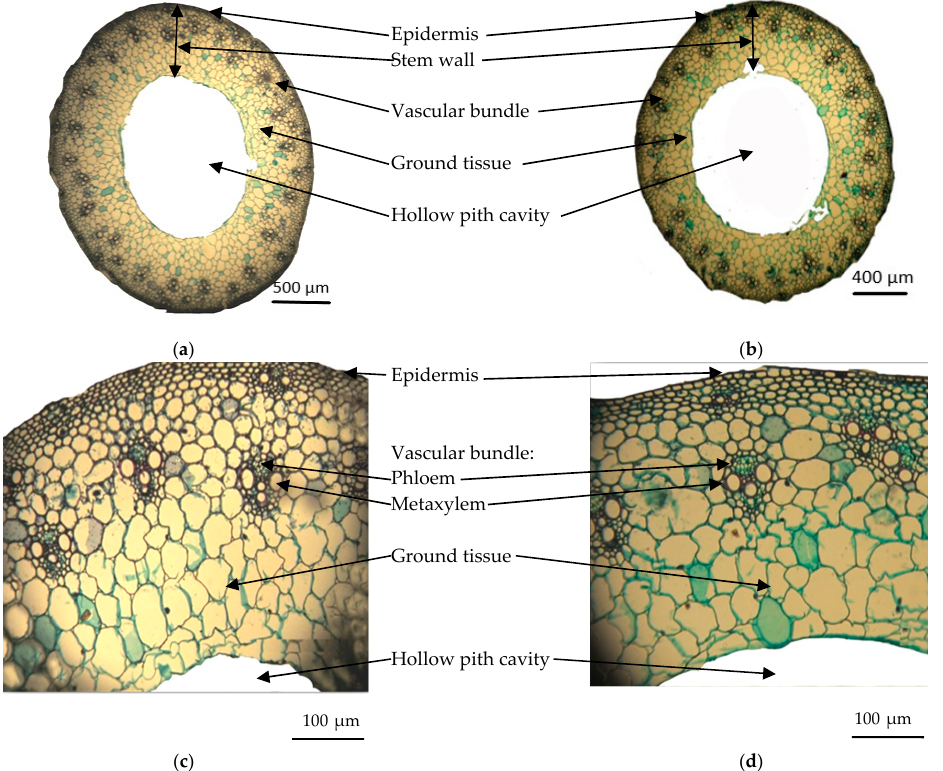
Figure 4. Transverse sections through the median portion of the main stems of wheat plants grown for 56 days at 0.23 and 6.0 dS m − 1 salt stress (×68) ( a ) 0.23 dS m − 1 ; ( b ) 6.0 dS m − 1 , and magnified portion from transverse sections shown in ( a , b ) (×330); ( c ) 0.23 dS m − 1 ; ( d ) 6.0 dS m − 1 . Table 2. Histological characteristics of transverse sections of median portion of the main stems and leaves of wheat plants after subjecting to 0.23 and 6.0 dS m − 1 salt stress for 56 days.